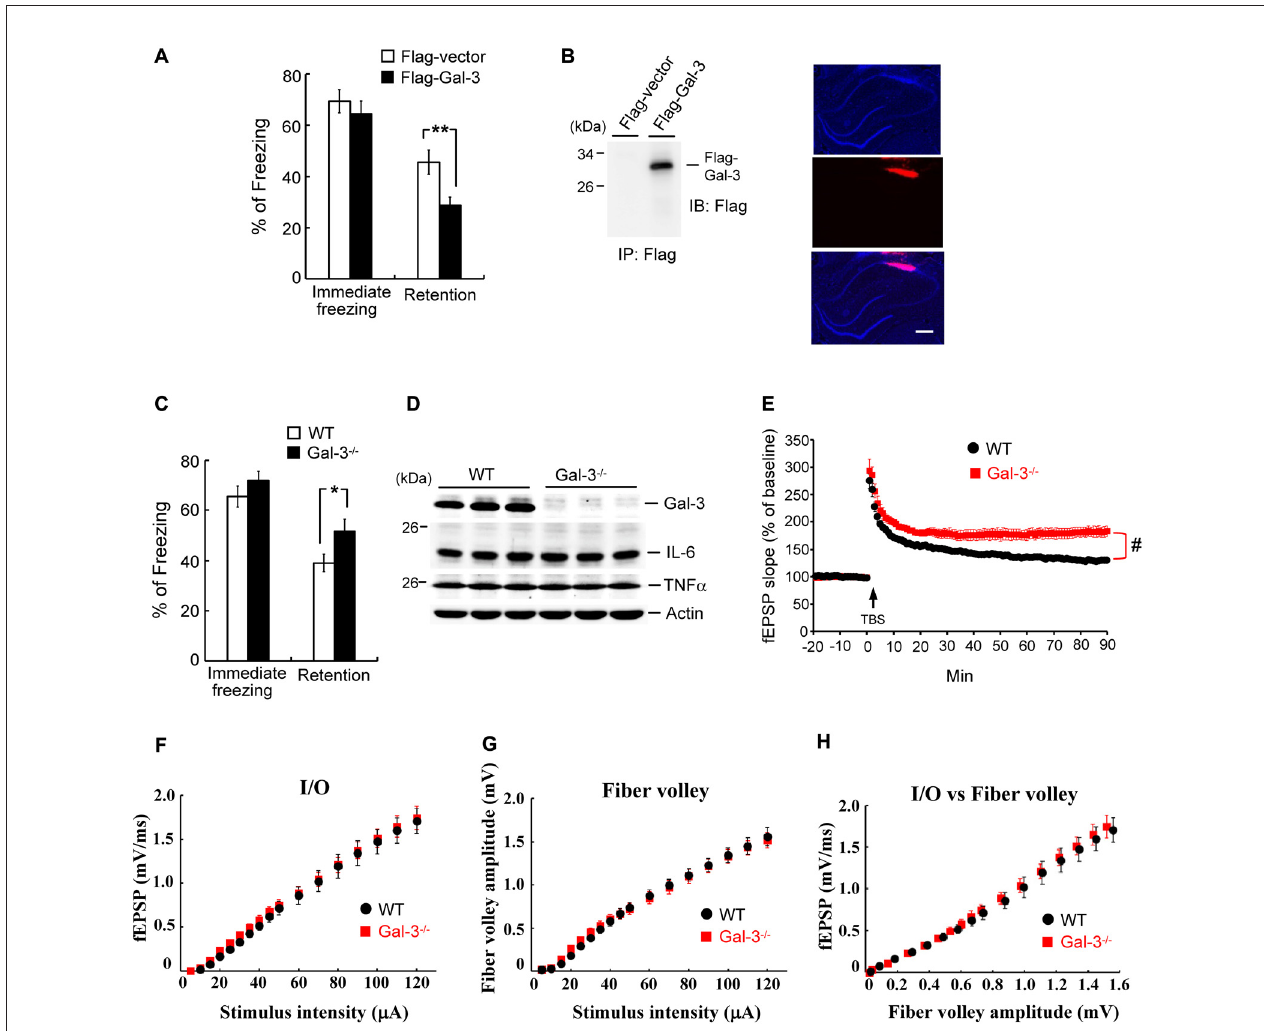
FIGURE 3 | Overexpression of galectin-3 impairs fear memory but fear memory is enhanced in galectin-3 knockout (KO) mice. (A) Immediate freezing response ( t ( 1,14 ) = 0.74, P > 0.05) and retention performance ( t ( 1,14 ) = 2.95, P = 0.01) in rats transfected with Flag-galectin-3WT plasmid or Flag-vector plasmid. N = 8 each group. (B) Immunoprecipitation and immunoblotting against the Flag tag confirming the expression of galectin-3 in Flag-galectin-3 transfected animals (left). Immunohistochemistry with Cy3-conjugated secondary antibody against Flag confirming the expression of galectin-3 in rat CA1 area (right). Scale bar